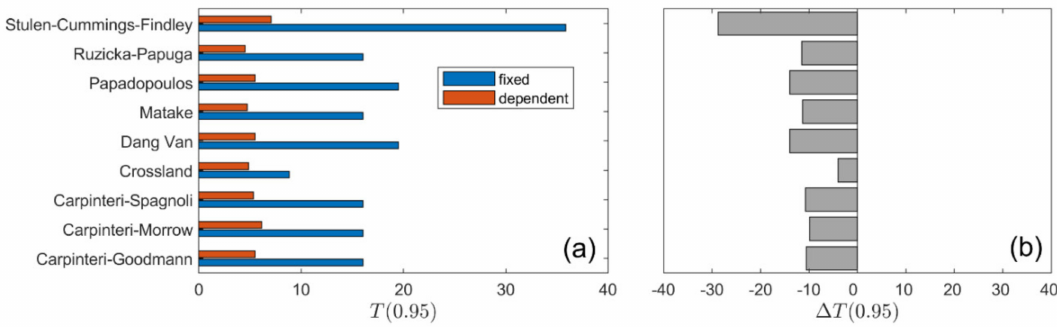
Figure 11. Summary comparison of calculation results for the analysed models under R = − 0.5 for S355 steel: ( a ) fatigue scatter band and ( b ) change in the fatigue scatter band for all analysed fatigue models.